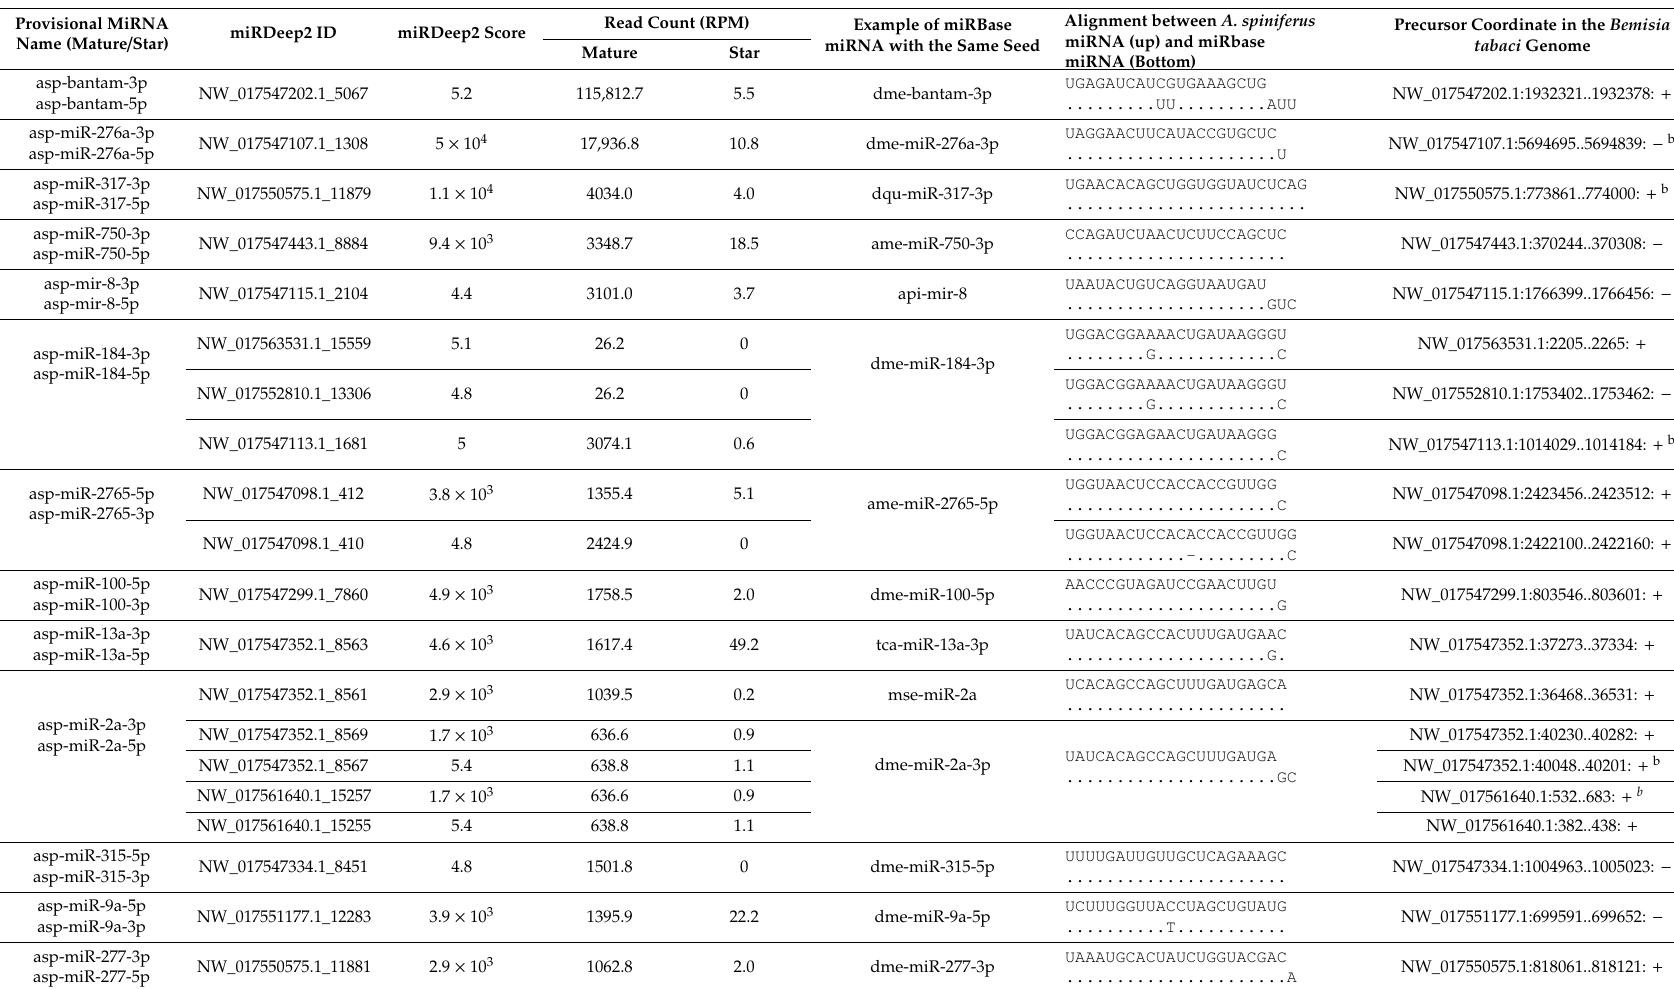
Table 1. Canonical miRNAs detected by miRDeep2 tool using Aleurocanthus spiniferus small RNA reads, Bemisia tabaci genome, and miRBase